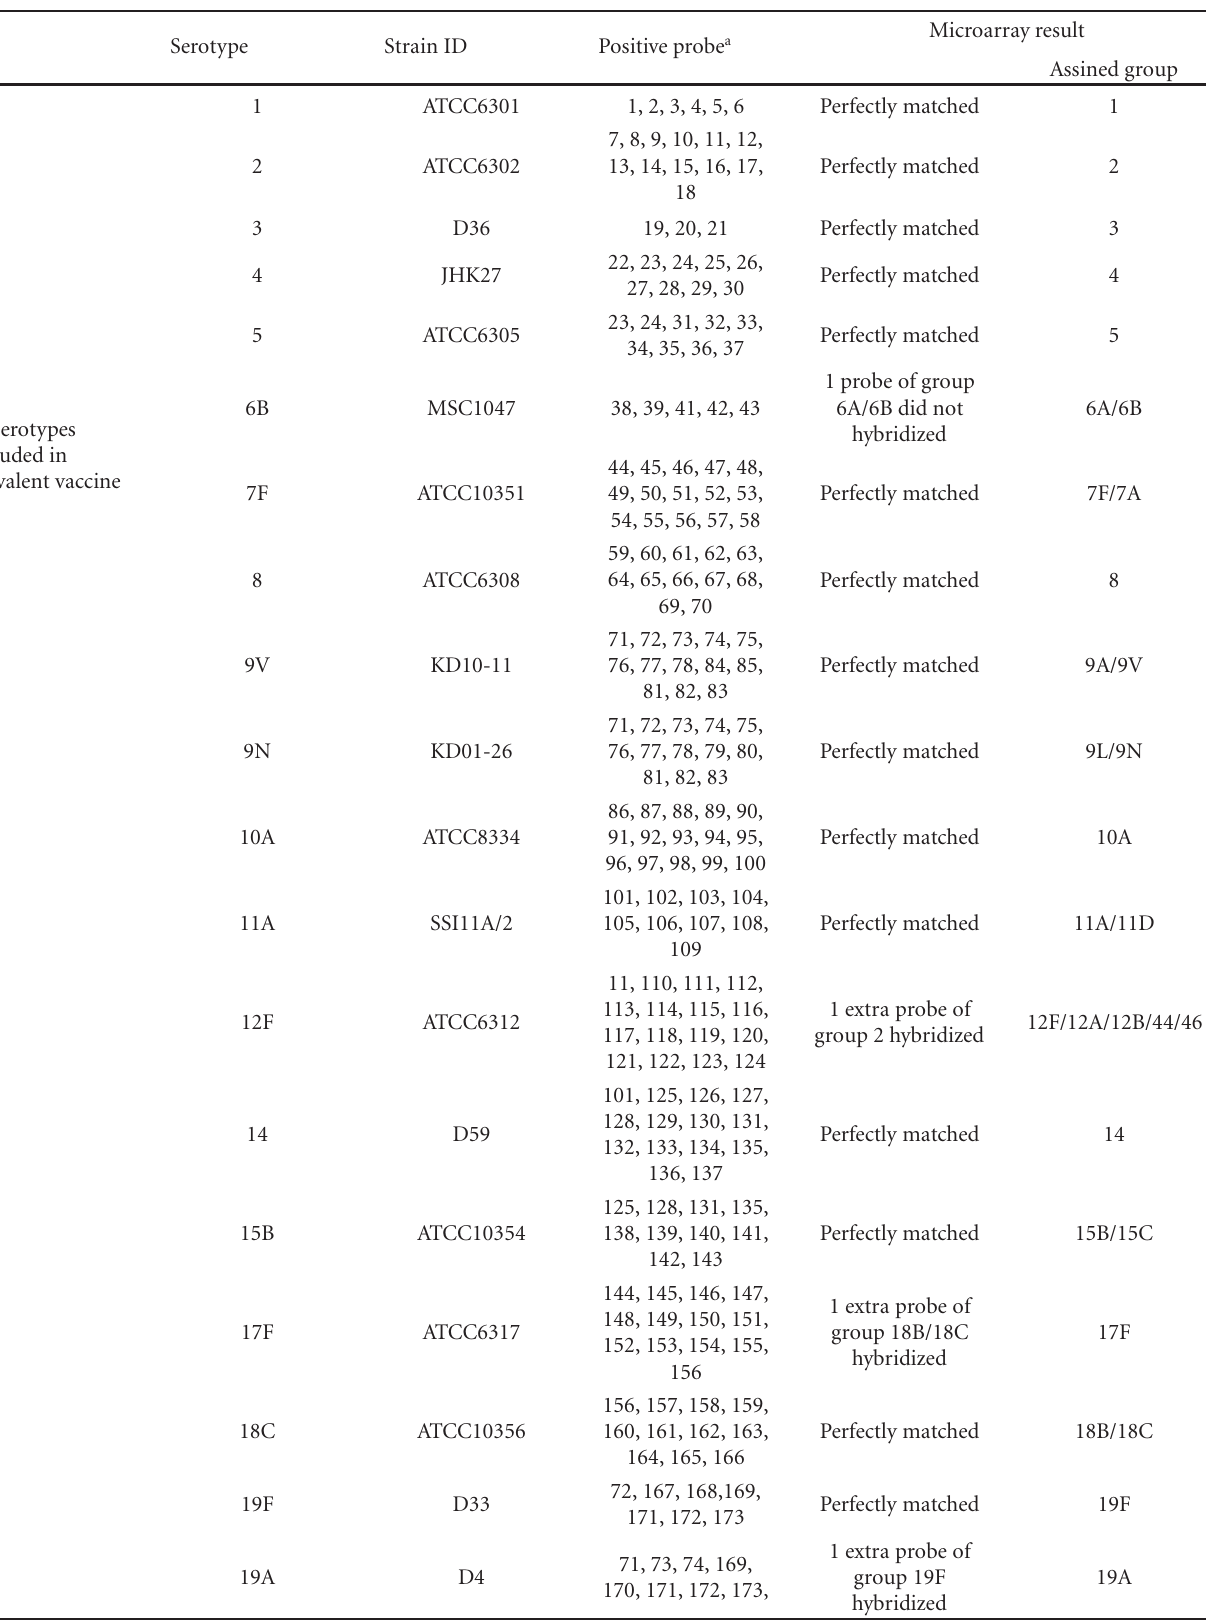
Table 4: Microarray results of each